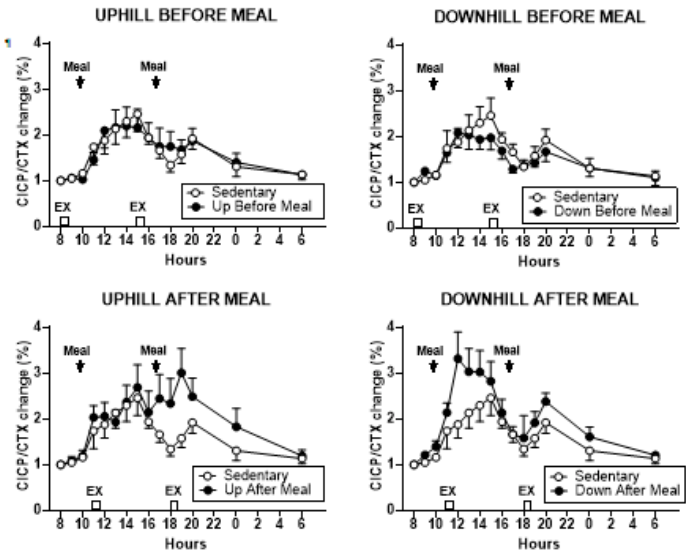
Figure 5. Percent changes in serum CICP / CTX ratio between sedentary trial and exercise trials performed before meals is shown at the top (left: UBM, right: DBM), and after exercise trials performed after eating, is shown at the bottom (left: UAM, right: DAM). CICP / CTX AUCs were significantly higher after second exercise bout after the meals in the UAM trial (bottom, left) and after first such bout in the DAM trial (bottom,